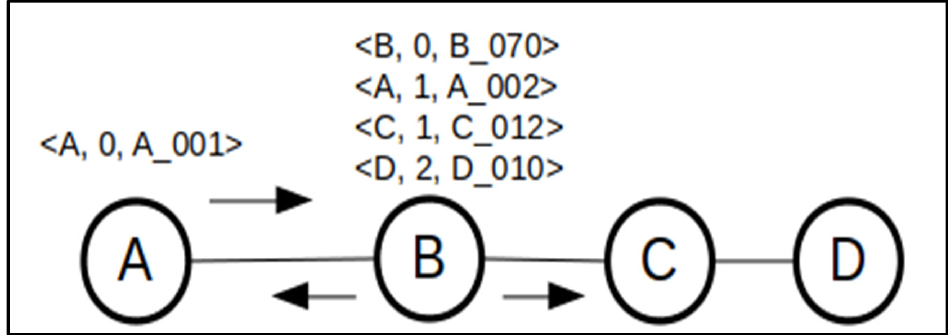
Figure 1. Example of a routing mechanism of exchanging messages in the DSDV routing protocol.